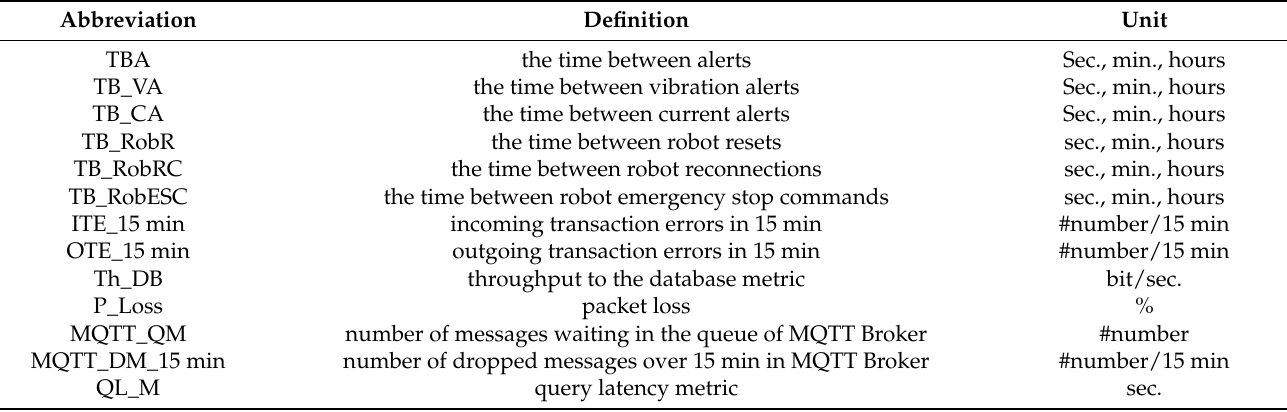
Table 1. The KPIs and Metrics in the